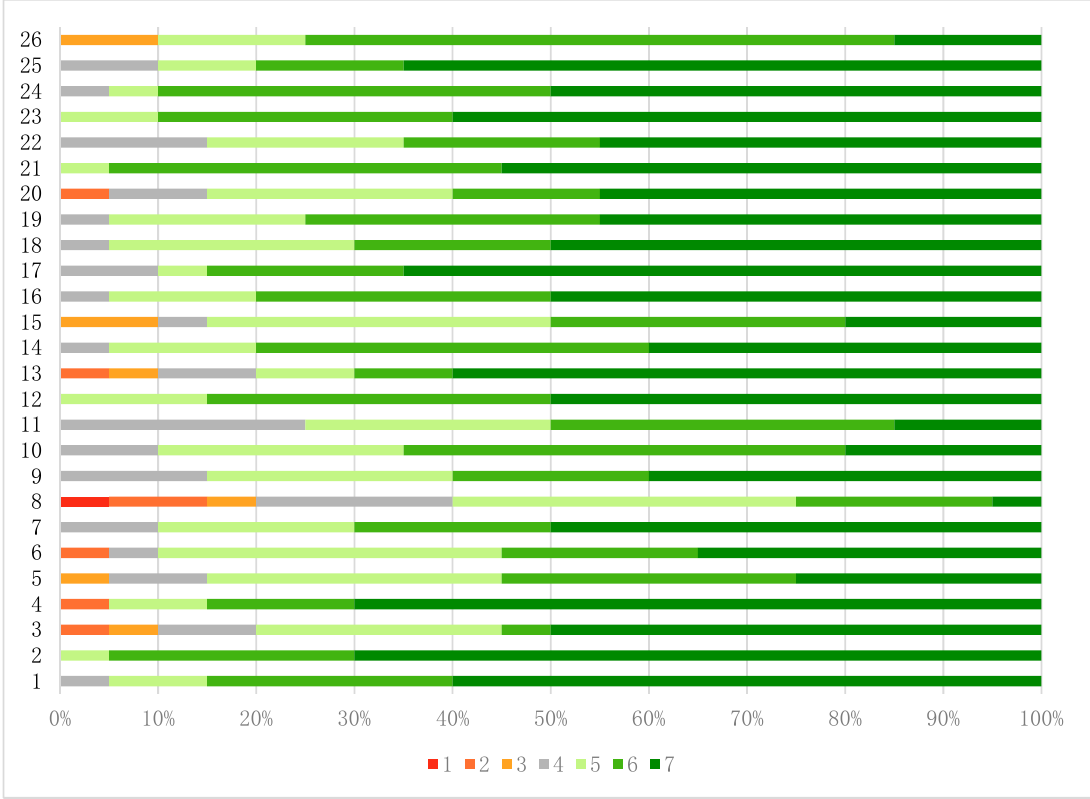
Figure 4. Distribution of answers per item for the prototype